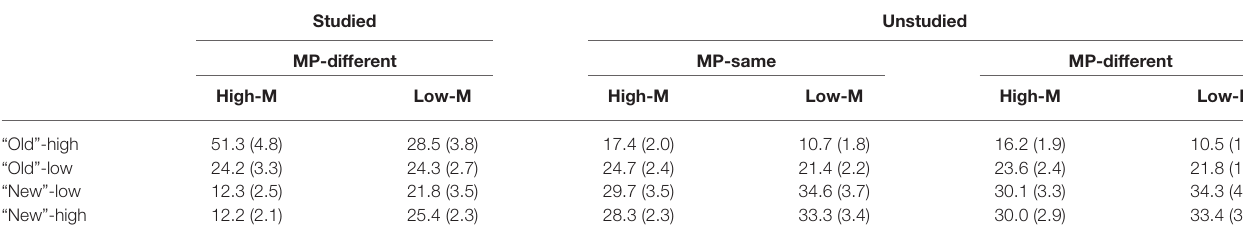
TABLE 2 | Mean percentage of responses in each condition . Studied Unstudied MP-different MP-same MP-different